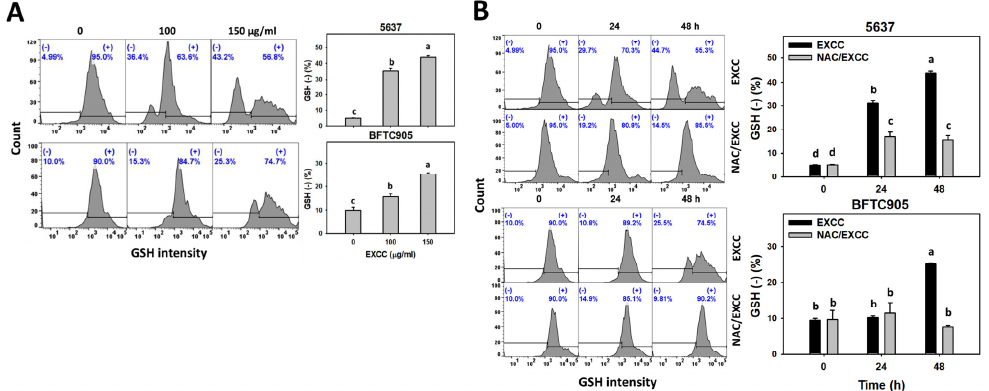
Figure 8. GSH change by EXCC. ( A ) GSH assay of EXCC. Two bladder cancer cell lines (5637 and BFTC905) were tested. Cells were treated with control (0.1% DMSO) and EXCC (100 and 150 µ g/mL) for 48 h. ( − ) represents GSH ( − ) population. ( B ) GSH assay of NAC/EXCC. NAC/EXCC is the NAC pretreatment (10 mM, 1 h) coupled with EXCC posttreatment (150 µ g/mL, 24 and 48 h). Statistical lower-case letters were given to each treatment. Non-overlapping letters between different treatments indicate significant results ( p < 0.05). Data, means ± SD ( n = 3). For example (5637 cells in Figure 8B), the EXCC (black color) 0, 24, and 48 h indicating “d, b, and a” show significant results between each other because these letters were non-overlapping. In contrast, EXCC 0 (black color) and NAC/EXCC (gray color) 0 h indicating “d” show nonsignificant results because these letters overlap.